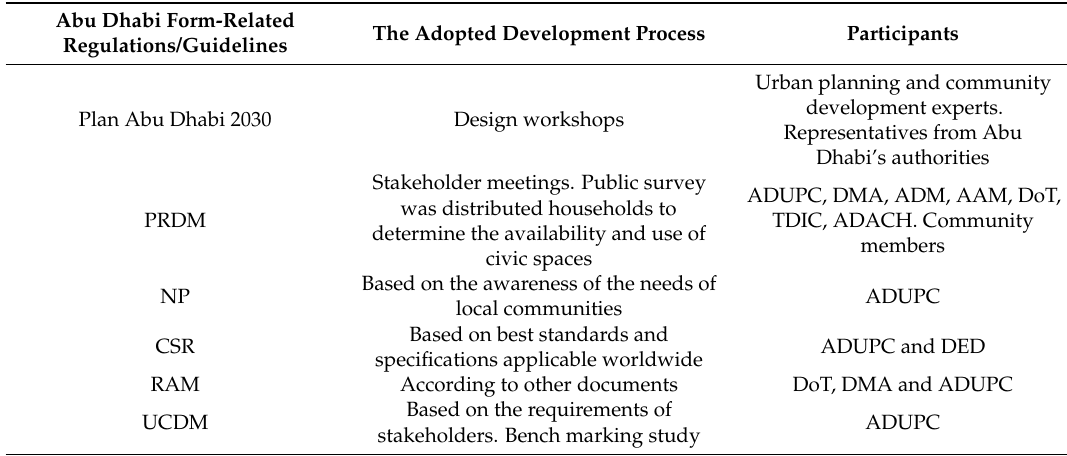
Table 2. The process and participants for developing some of urban form-related regulations and guidelines of the new urban neighborhoods in Abu